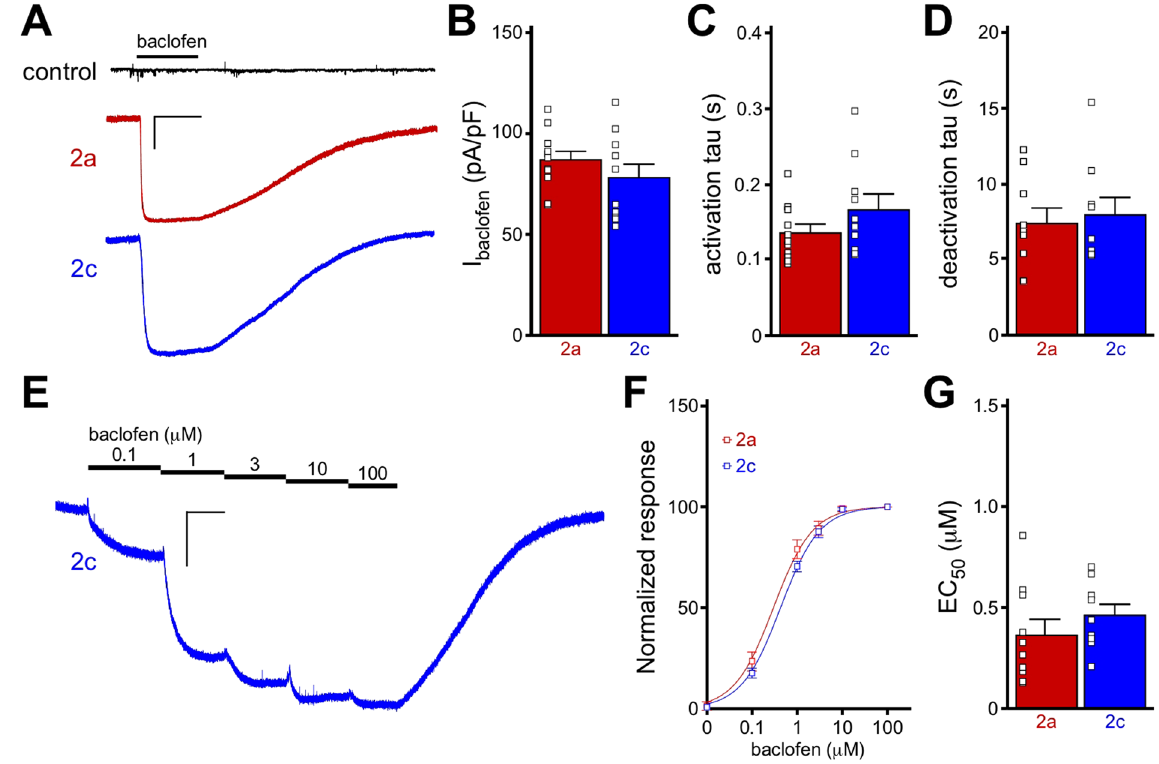
Figure 1. Functional comparison of GIRK2a and GIRK2c in HEK cells. ( A ) Whole-cell currents (V hold = − 70 mV) evoked by baclofen (100 μ M) in HEK cells expressing GABA B R, GIRK1, and either GIRK2a (red) or GIRK2c (blue). No current was evoked by baclofen in cells expressing only GABA B R (control, black). Scale: 500 pA/10 s. ( B ) Summary of baclofen-induced, steady-state current densities (I baclofen , pA/pF) in HEK cells expressing GIRK1/GIRK2a or GIRK1/GIRK2c ( t 19 = 1.1, P = 0.29; n = 10–11/group). Individual data points are represented as small squares overlapping the relevant bar in the plot. ( C,D ) Activation ( t 19 = 1.5, P = 0.16) and deactivation ( t 16 = 0.4, P = 0.72) kinetics for baclofen-induced currents in HEK cells expressing GIRK1/GIRK2a or GIRK1/GIRK2c (n = 9–11/group). ( E ) Representative concentration-response experiment for a HEK cell expressing GABA B R and GIRK1/GIRK2c. Scale: 500 pA/10 s. ( F,G ) Summary of concentration- response experiments for baclofen-induced currents in HEK cells expressing GIRK1/GIRK2a or GIRK1/ GIRK2c ( t 17 = 1.0, P = 0.32; n = 9–10/group). Currents were normalized to the response evoked by 100 μ M baclofen in each